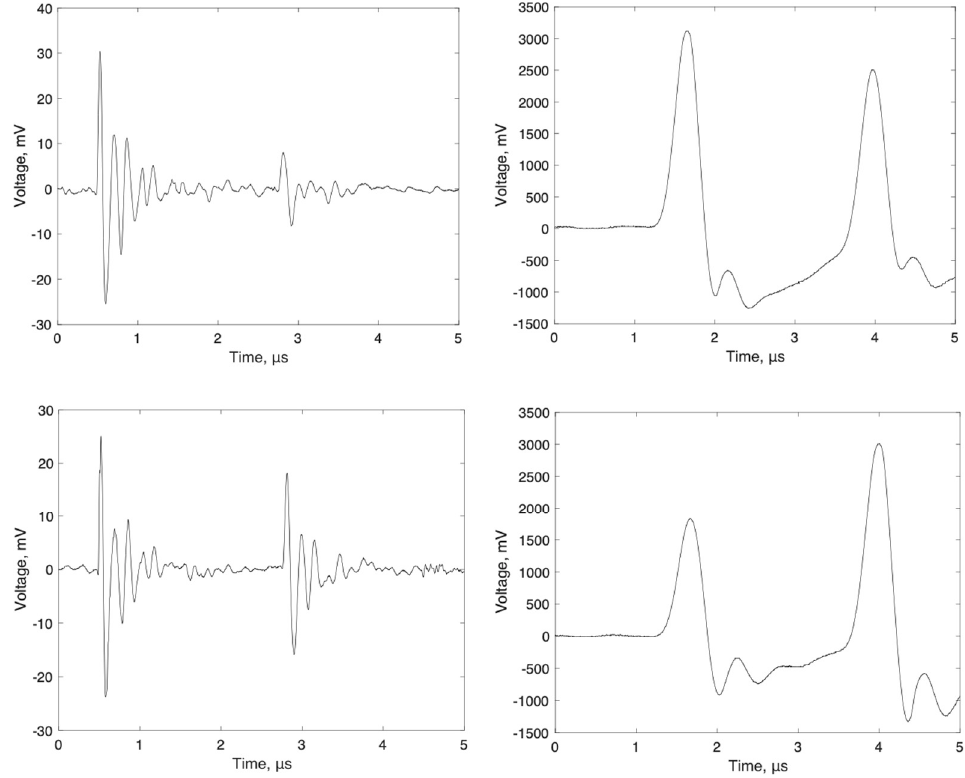
Figure 3. Examples of measured responses to pulses injected at the far end of the cable ( top row ) and the near end of the cable ( bottom row ). ( Left ): HFCT; ( Right ): IEC 60270 − compliant conven- tional system.